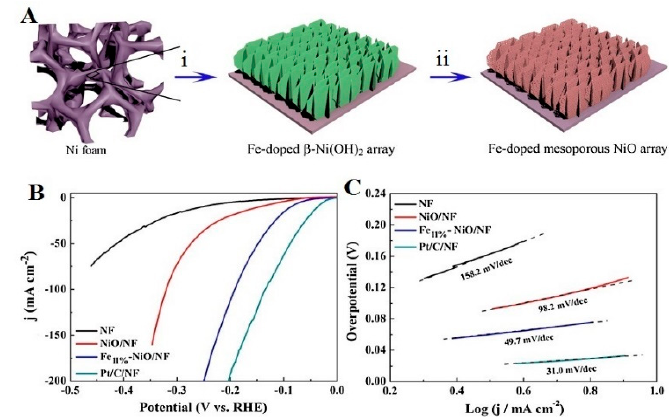
Figure 7. ( A ) Schematic illustration of the formation of Fe-doped mesoporous NiO on Ni foam. (i) Solvothermal synthesis of Fe-doped β -Ni(OH) 2 and (ii) the calcination of Fe-doped β -Ni(OH) 2 in air to produce Fe-doped mesoporous NiO array. ( B ) Polarization curves of NF (nickel foam), NiO / NF, Fe 11% -NiO / NF and Pt / C / NF. ( C ) Tafel slopes of NF, NiO / NF, Fe 11% -NiO / NF and Pt / C / NF (reprinted with permission from ref [49]. Copyright © 2018, Elsevier).